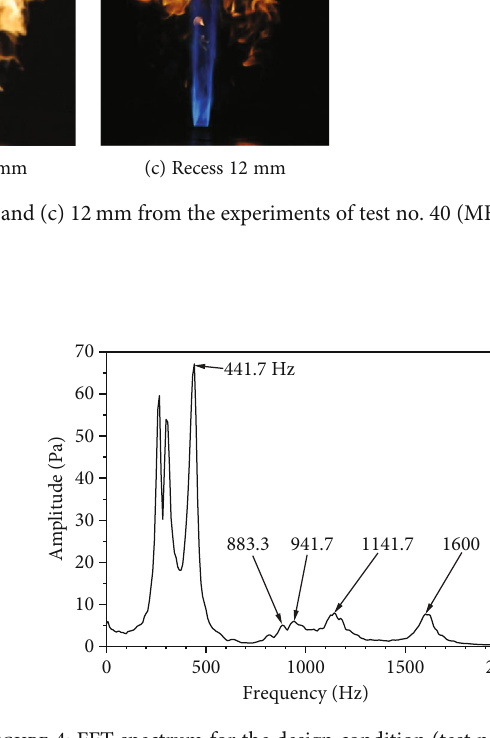
Figure 4: FFT spectrum for the design condition (test no. 40) with recess of 8